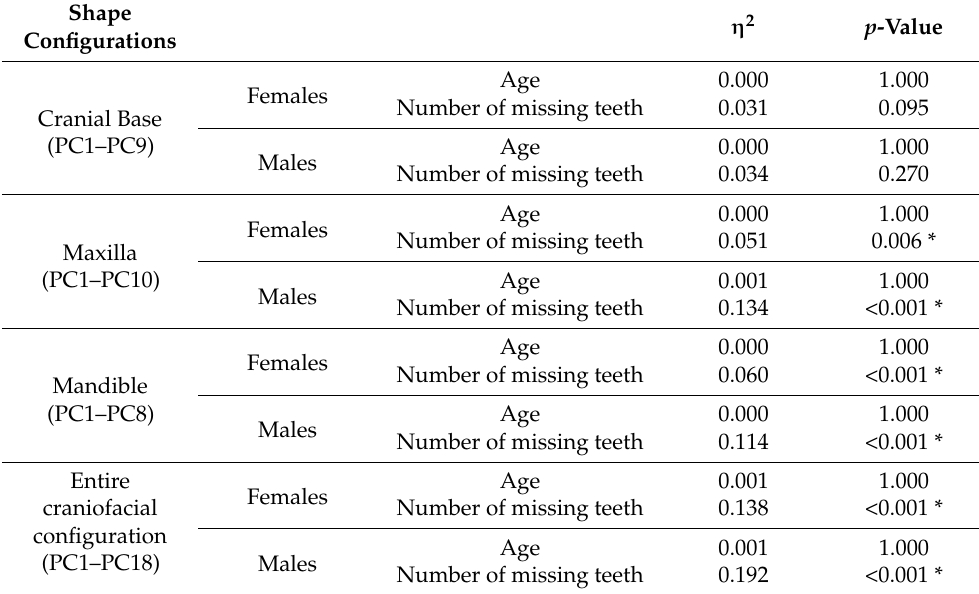
Table 3. Multivariate regression of shape (without allometry) on age and number of missing teeth, without considering third molars, in female ( n = 476) and male ( n = 332) samples. Each shape configuration was described with the number of PCs explaining more than 85% of shape variation, as assessed with the broken-stick